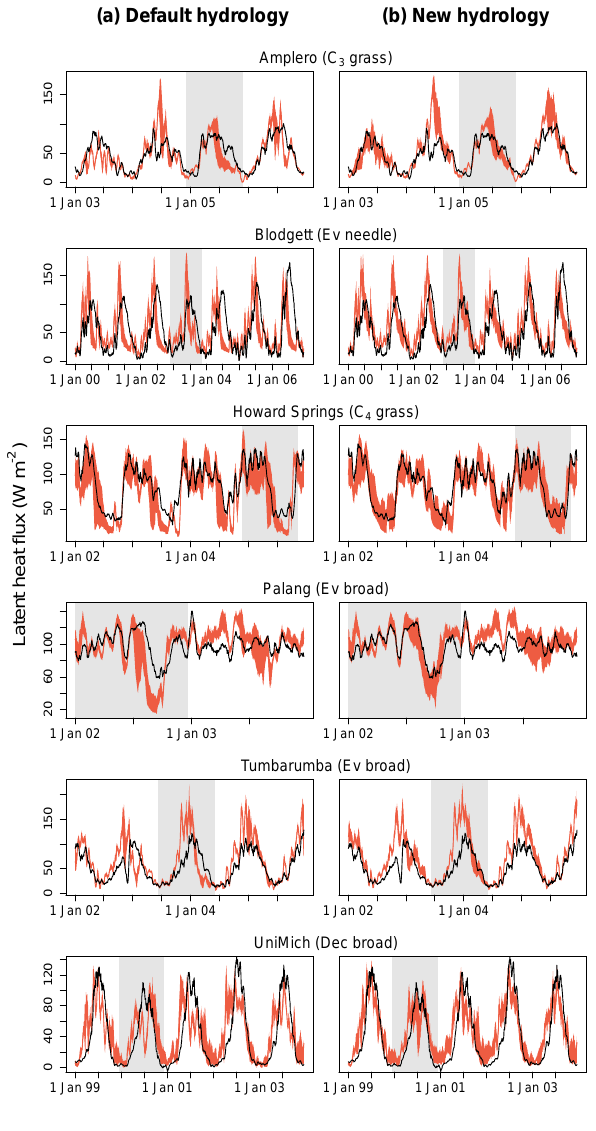
Figure 2. The range in simulated latent heat (red) during the whole observational data period using the default (left panel) and new (right panel) hydrological schemes with alternative LAI, g s and soil parameterisations. Observed latent heat is shown in black. The grey shading denotes the selected 1-year